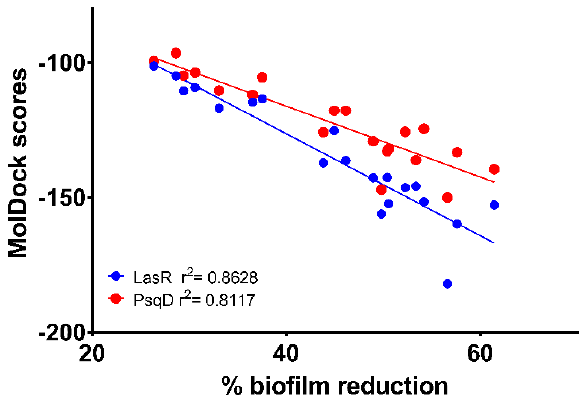
Figure 5. Correlation of the percentage of biofilm inhibition against the docking scores.